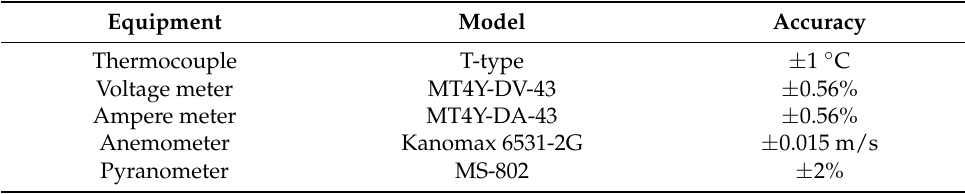
Table 3. Specification of measuring